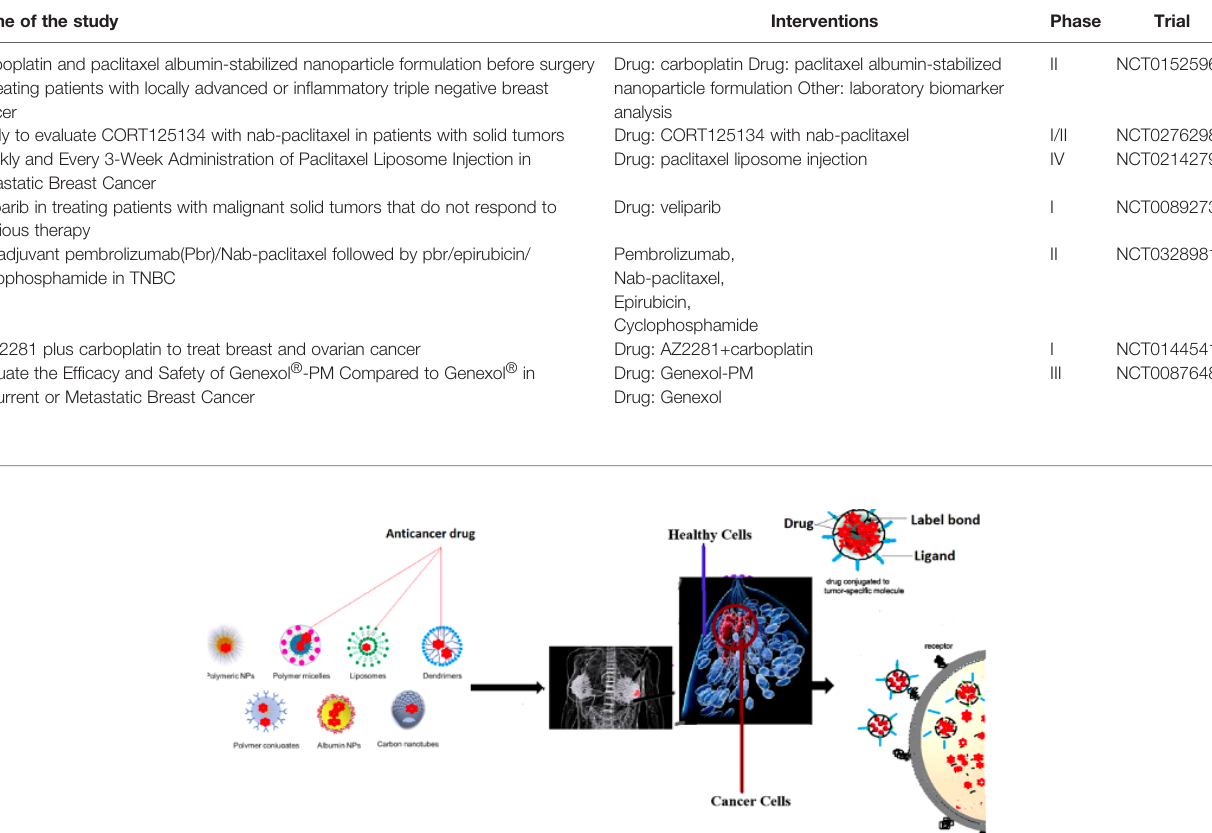
TABLE 3 | Clinical trials in the area of nanotechnology and triple-negative breast cancer.